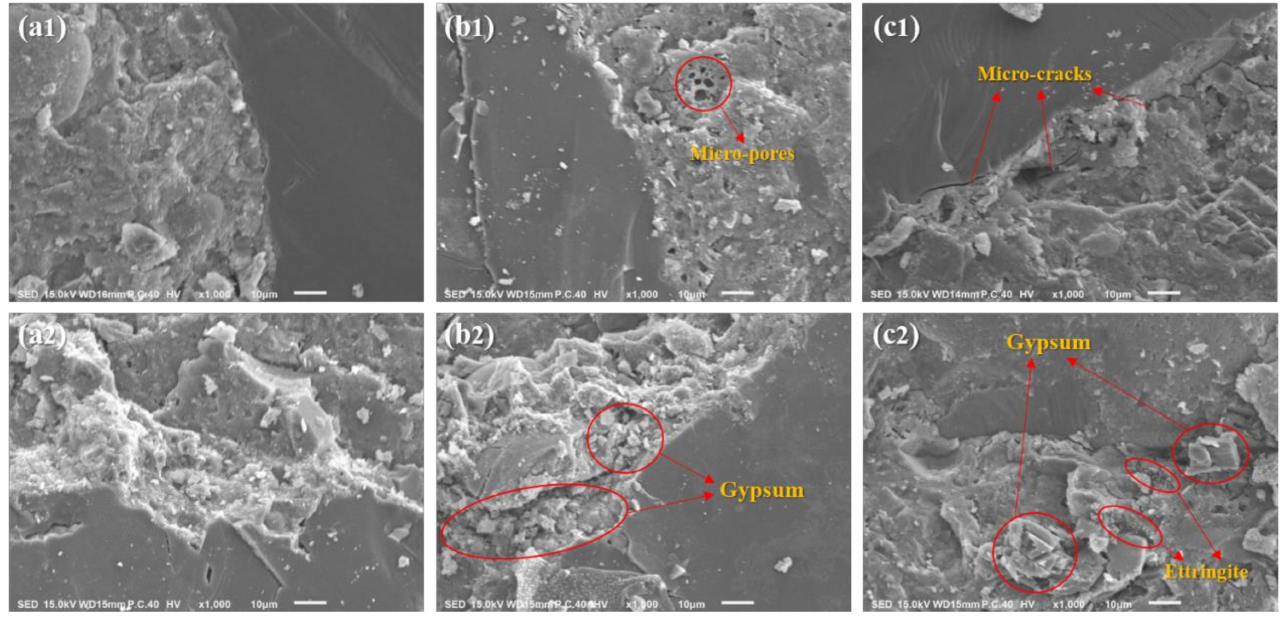
Figure 9. SEM images of ( a1 ) INPC, ( b1 ) IRPC 1-100 and ( c1 ) IRPC 2-100 before sulfate attack, and ( a2 ) INPC, ( b2 ) IRPC 1-100 and ( c2 ) IRPC 2-100 after 60 sulfate wetting-drying